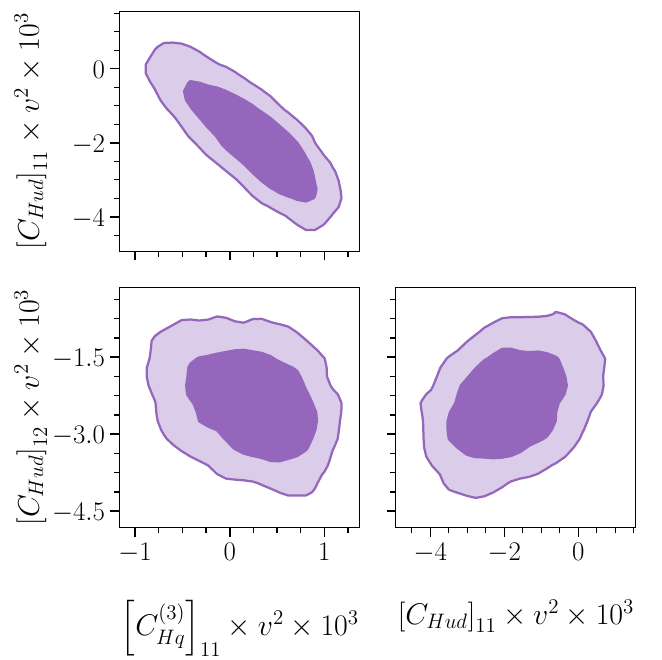
h i C (3) , [ C Hud ] , and Hq 11 11